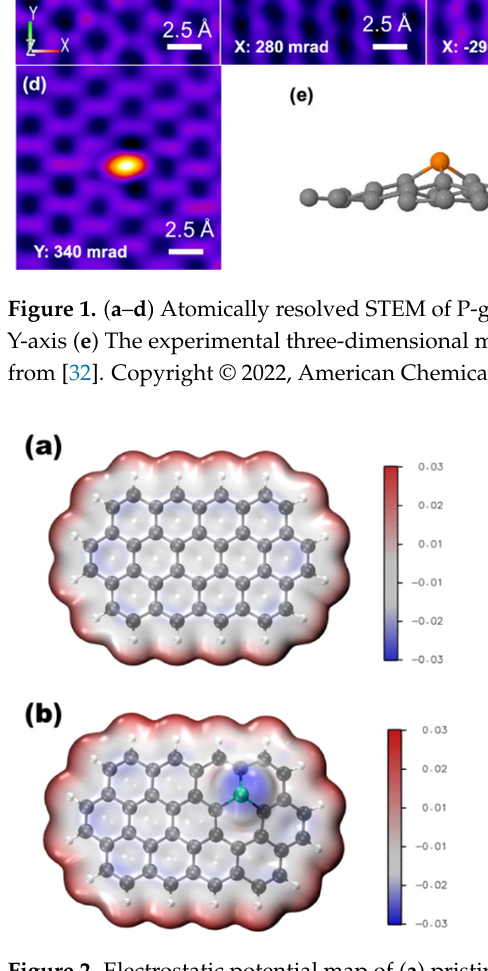
Figure 2. Electrostatic potential map of ( a ) pristine graphene, ( b ) P-graphene.